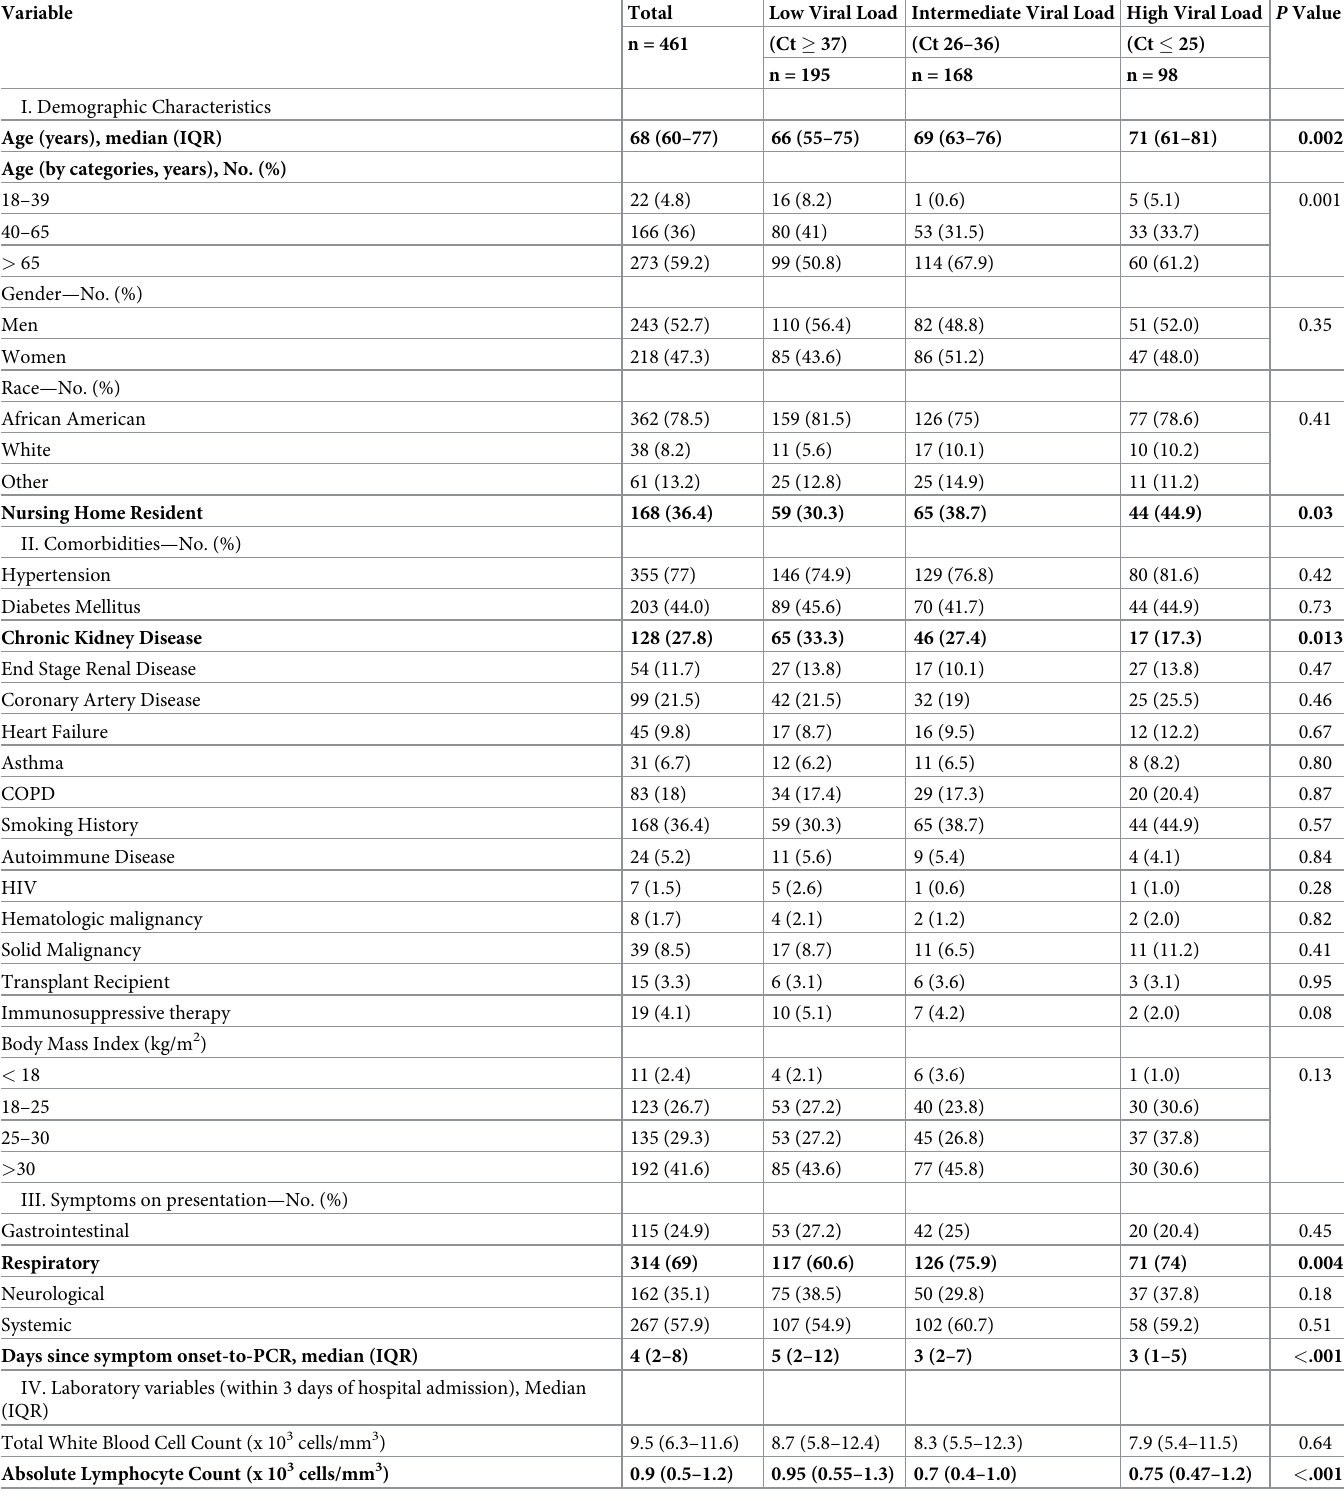
Table 1. Baseline characteristics of hospitalized patients with SARS-CoV-2 infection stratified by initial viral load category.